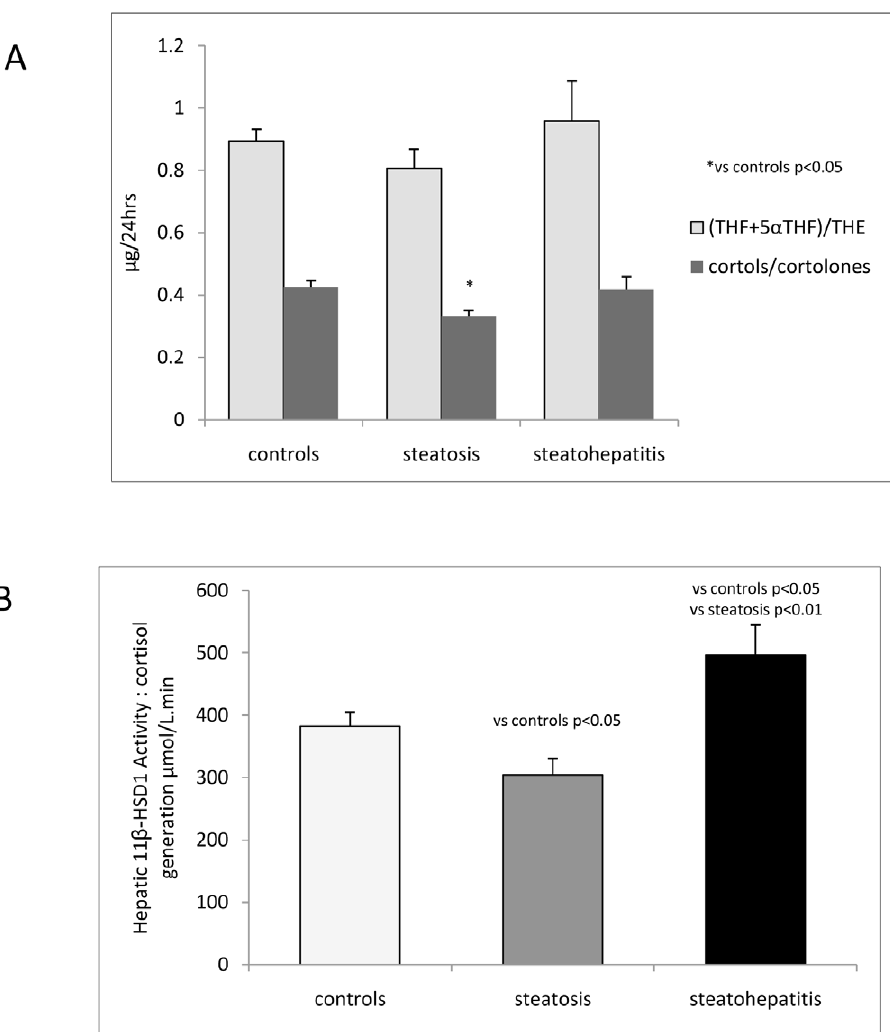
Figure 2. 11 b -HSD1 activity assessed by: (A) 24 hr urine cortols/cortolones and 5 a THF + THF/THE ratios (mean 6 SEM) in patients with steatosis and steatohepatitis compared with controls. (B) Hepatic cortisol generation measured by cortisol generation profiles (mean AUC 6 SEM) in patients with steatosis and steatohepatitis compared with controls.